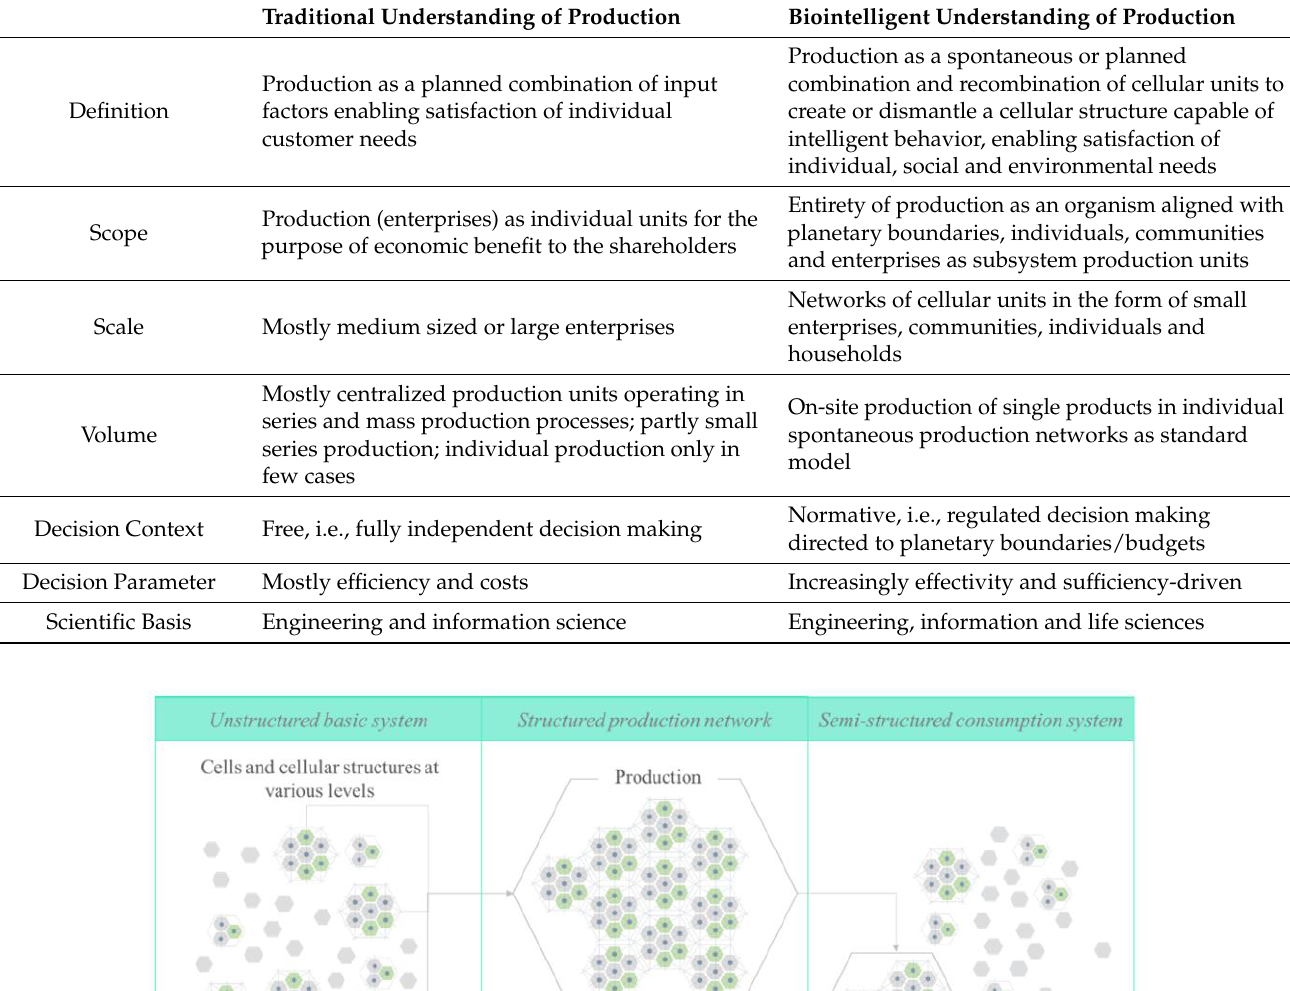
Table 1. Comparison of traditional and biointelligent understanding of production.